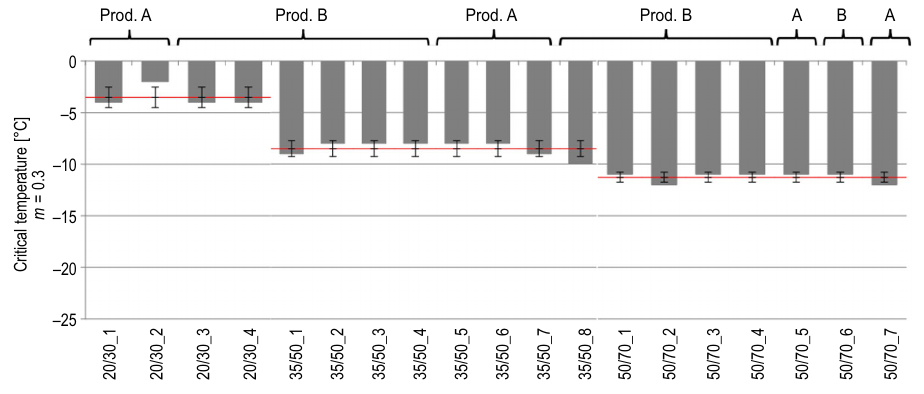
Fig. 9. Unmodified bitumen critical temperature according to BBR ( m = 0.300)